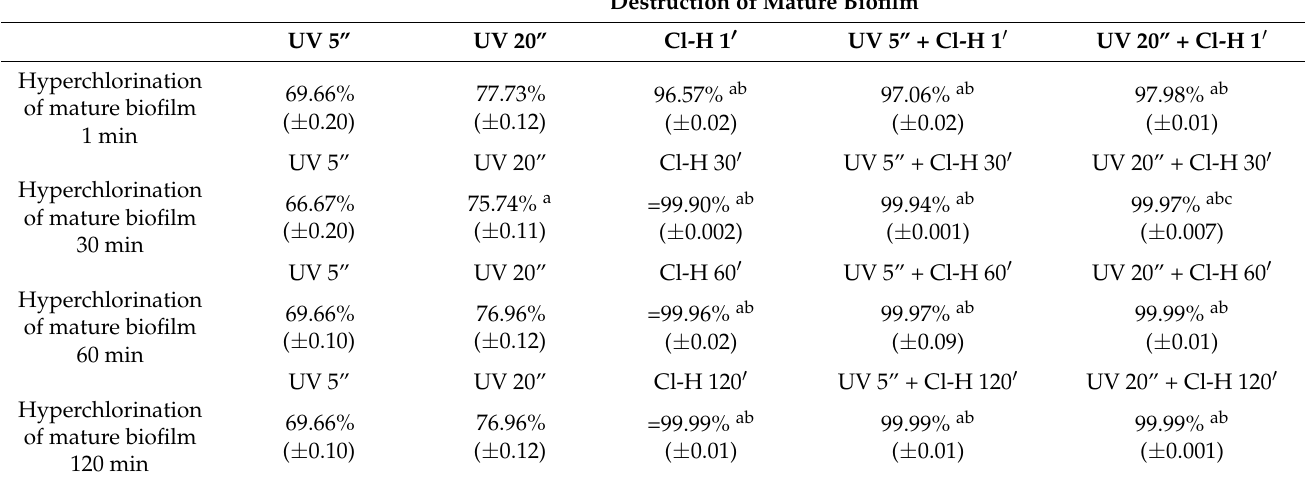
Table 1. Destruction of mature biofilm after different hyperchlorination treatments. Results are presented as a percentage (%). Small letters above the results indicate a statistically significant difference (a according to UV 5”; b according to UV 20”; c according to Cl ( p < 0.05), non-parametric Mann–Whitney U